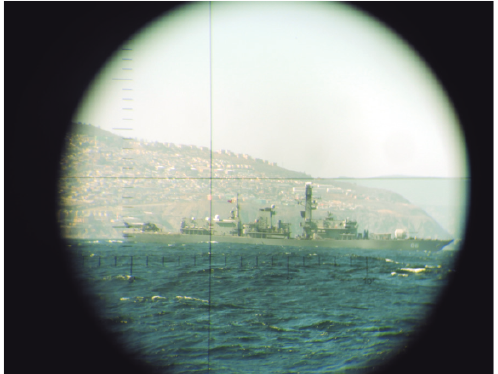
Figure 4. Periscope point of view. Source: adapted from